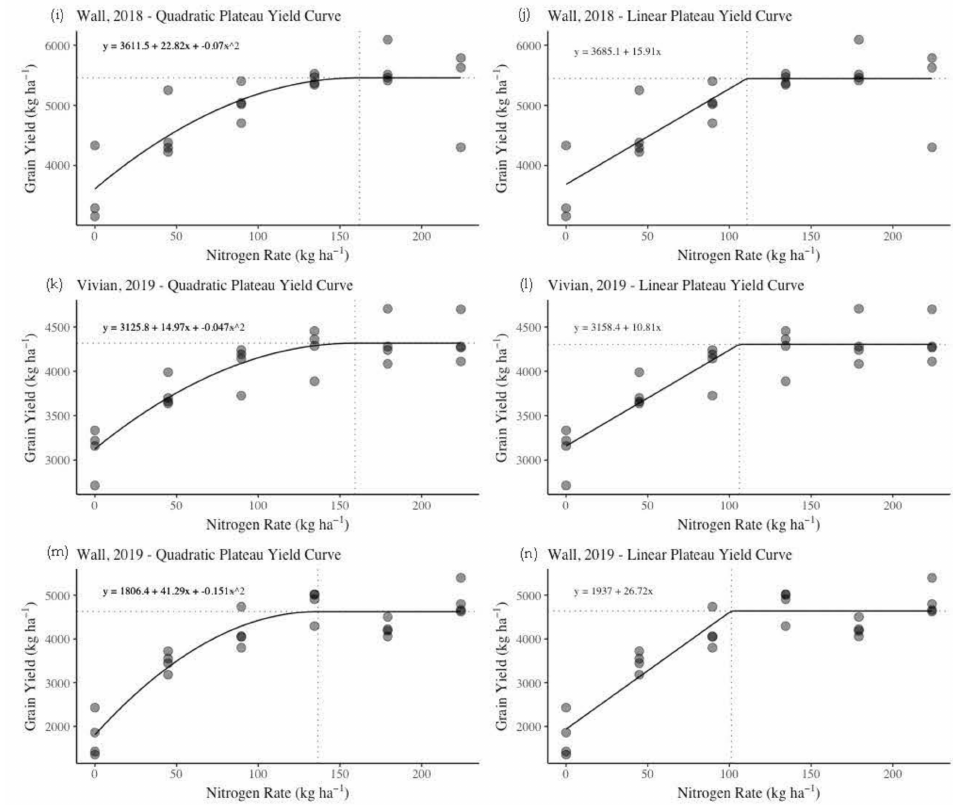
Figure 2. Graphical representation of quadratic plateau yield curve (left column) and linear plateau yield curve (right column) depicting relationships between grain yield (kg ha − 1 ) on the Y-axis and nitrogen rate (kg ha − 1 ) on the X-axis at the three study locations over three years between 2017–2019. The circles in each graph represent the yield measurements (replications) for each N rate. The dotted horizontal and vertical lines represent the join point (N rate) for each site/year and plateau (grain yield). Equations in each graph represent Equations (1) and (3) depicting each site’s unique coefficients.